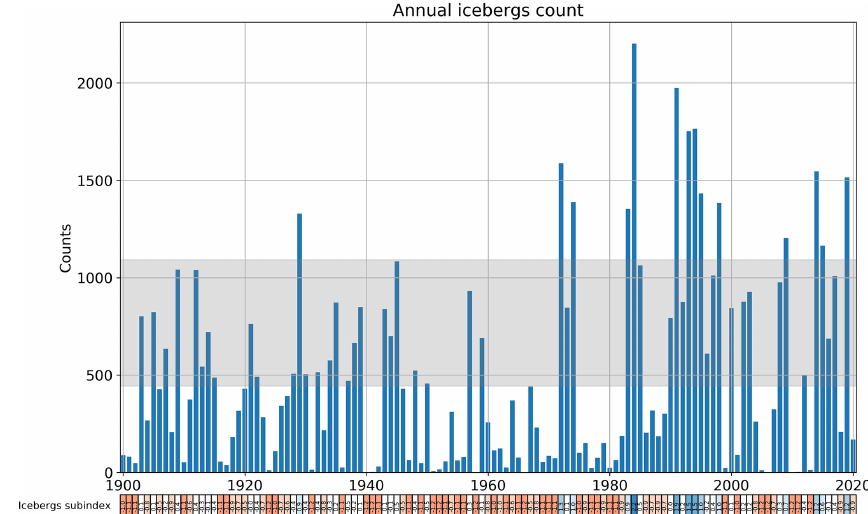
Figure A3. Same as Fig. 5 but using a climatology referenced to the 1981–2010 period.